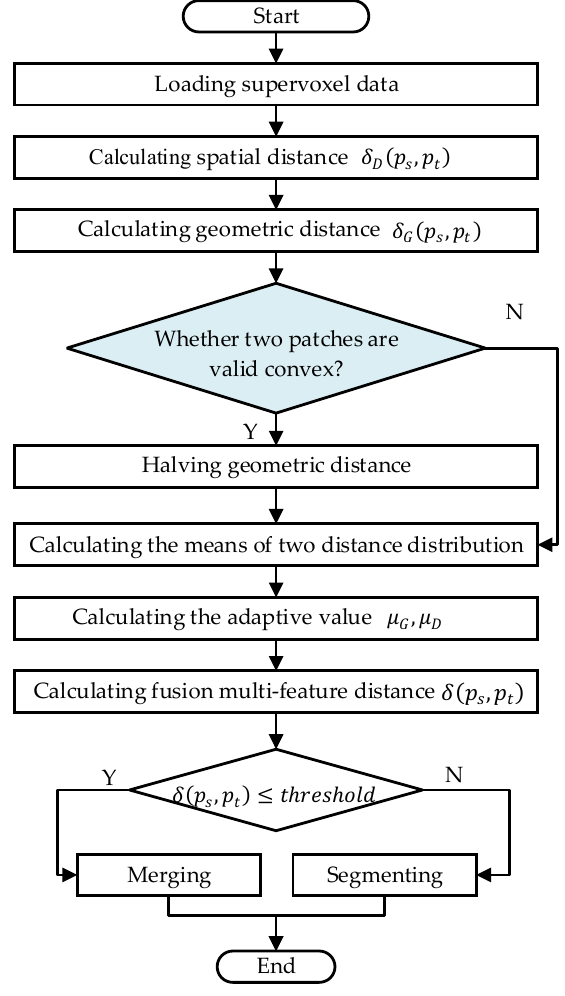
Figure 9. The process of the region merging algorithm.